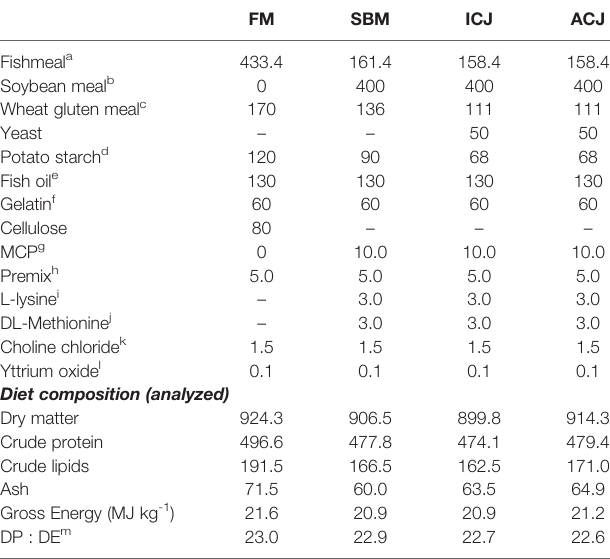
TABLE 1 | Formulation and nutritional composition of experimental diets according to Agboola et al.